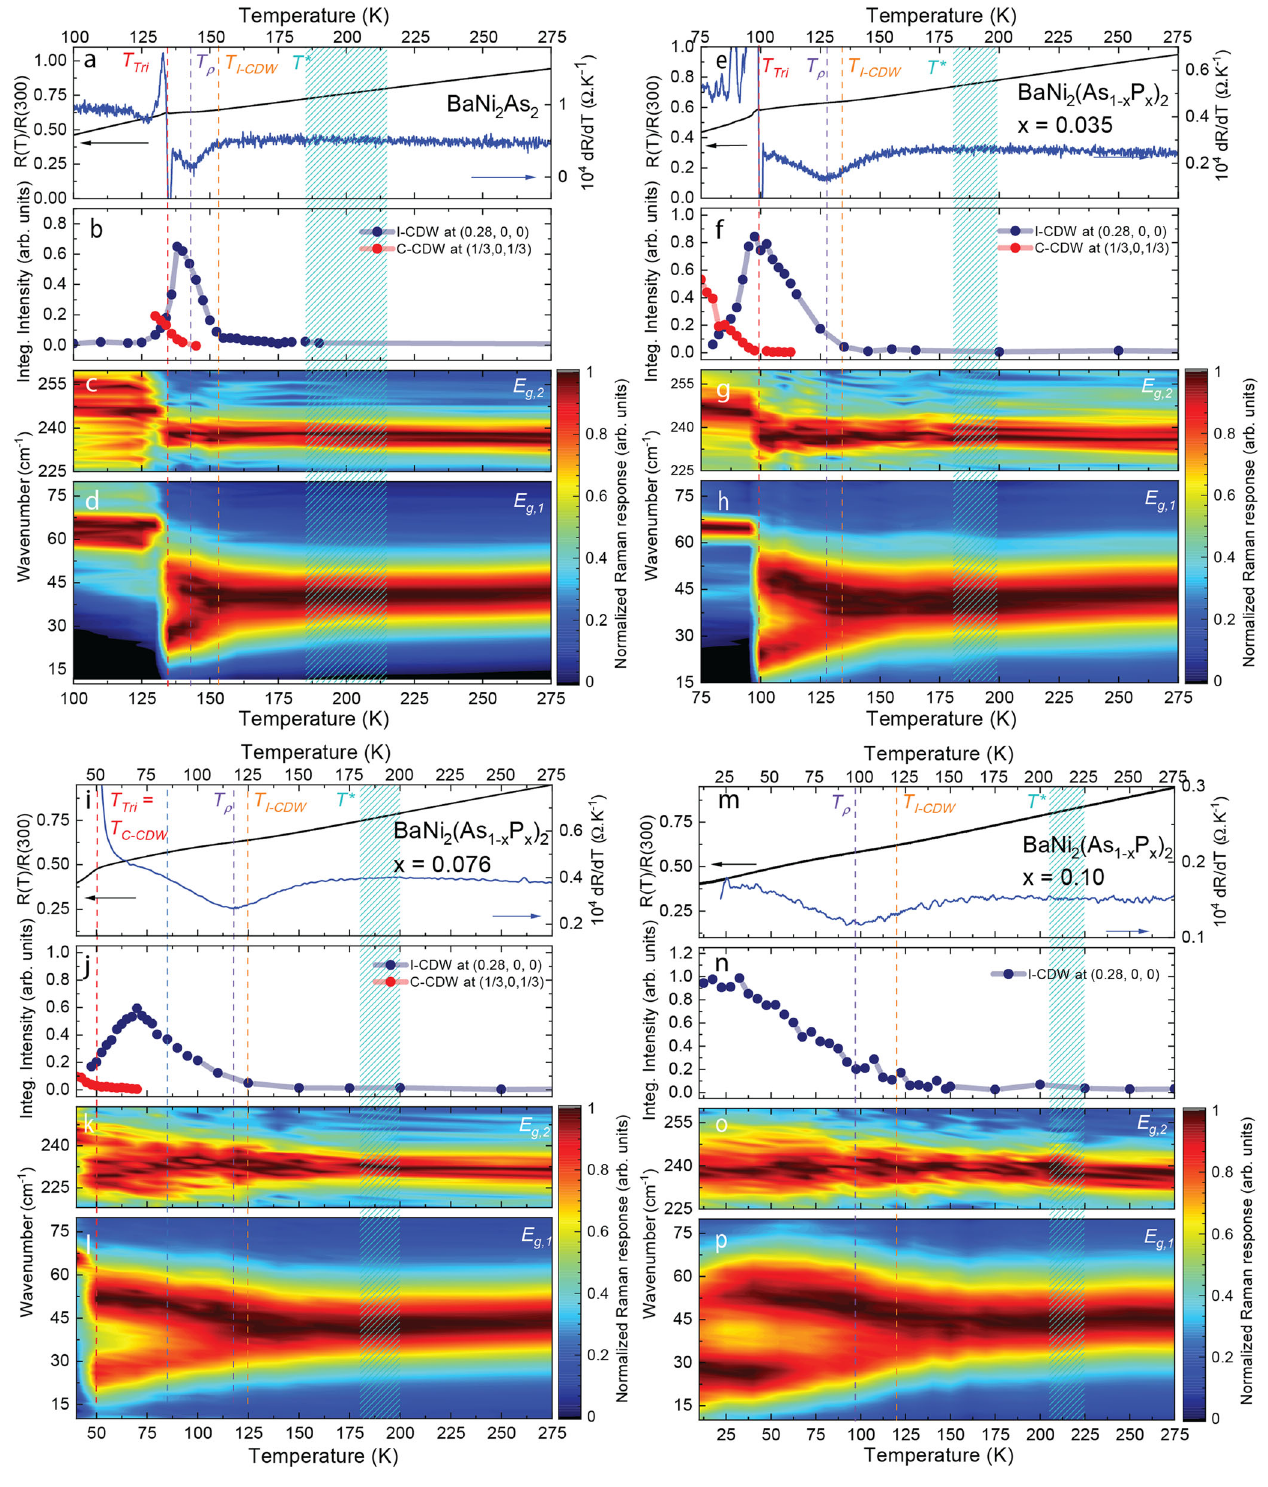
h same as ( a , b , c , d ) for BaNi 2 ð As 1 (cid:2) x P x Þ 2 ( x = 3.5%) ( i , j , k , l ) same as ( a , b , c , d ) for BaNi 2 ð As 1 (cid:2) x P x Þ 2 ( x =7.6%) ( m , n , o , p ) same as ( a , b , c , d ) for BaNi 2 ð As 1 (cid:2) x P x Þ 2 ( x = 10%). In each panel we have indicated the position of the triclinic transition (upon cooling) T Tri , of the local minimum of d R /d T T rho and of the temperature at which the I-CDW intensity starts to grow T I-CDW . The shaded area corresponds to the uncertainty on the determination of T * at which the E g phonon starts to